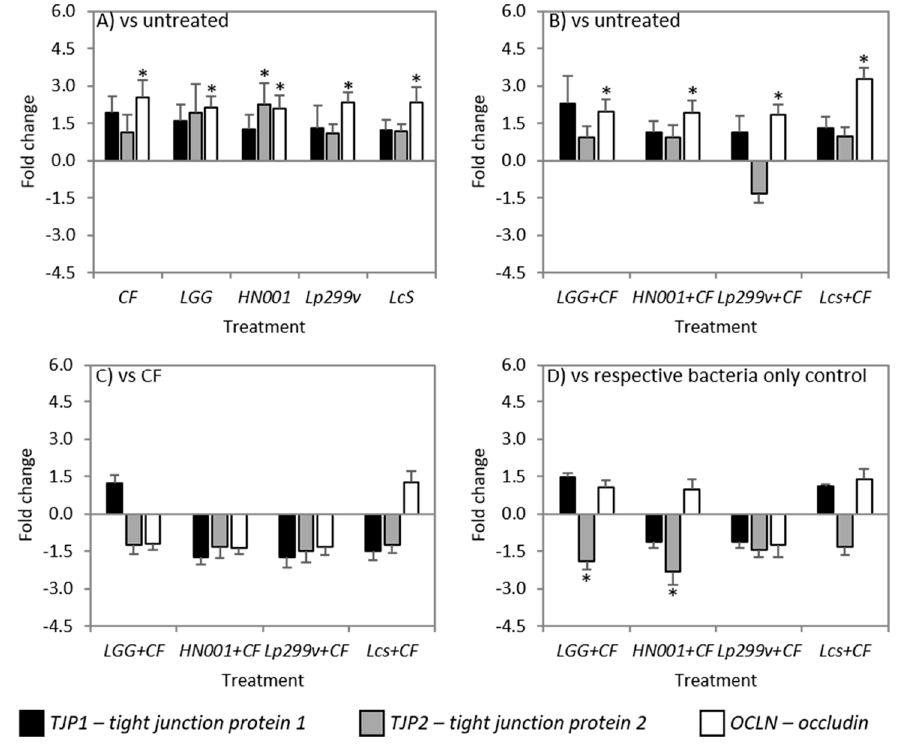
Figure 5. Fold change of TJP1 , TJP2 , and OCLN mRNA from Caco-2:HT29–MTX (90:10) co-cultures after 3 h incubation with ( A ) probiotic bacteria or a carbohydrate fraction (CF) relative to untreated co-cultures; ( B ) bacteria/CF combinations compared to untreated monolayers; ( C ) bacteria/CF combinations compared to monolayers incubated with CF; and ( D ) bacteria/CF combinations relative to bacteria only controls. Data are expressed as the mean fold change (±SEM) of three replicates across three independent experiments; n = 3 A statistically significant difference in fold change at ±1.5 is indicated by * ( P < 0.05). LGG = L. rhamnosus GG; HN001 = L. rhamnosus HN001; Lp299v = L. plantarum